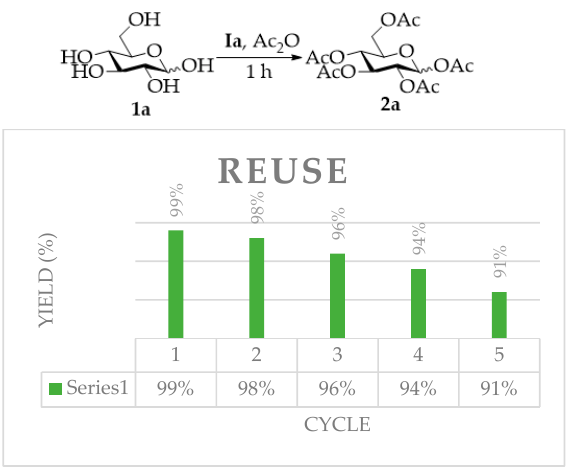
Figure 1. Recycling of Ia in the synthesis of penta-acetate D-glucose 2a.